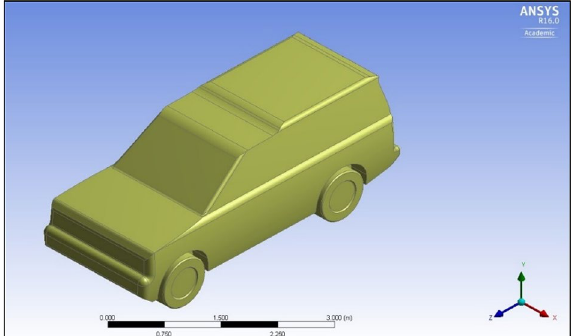
Figure 1. The original design of LR